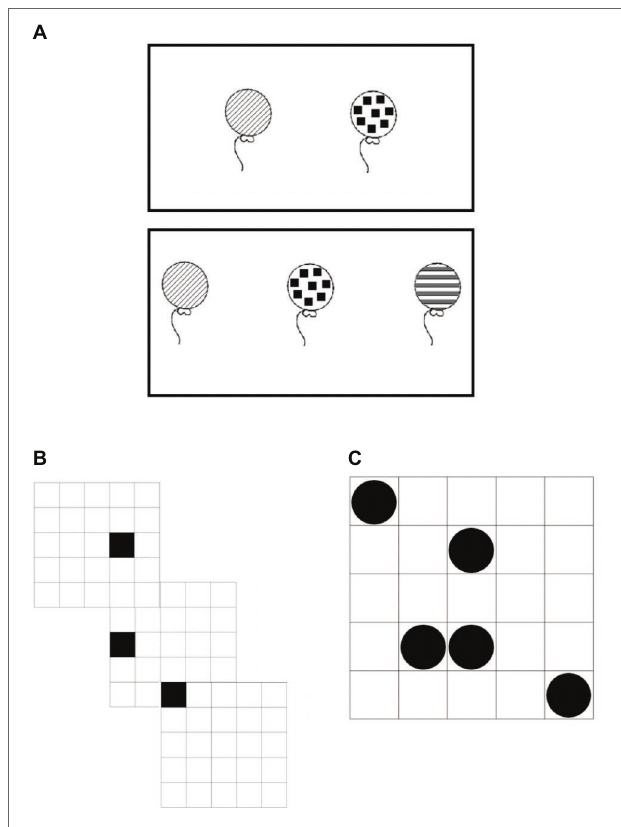
FIGURE 5 | Example VSWM tasks for (A) balloons, (B) sequential matrices, and (C) simultaneous